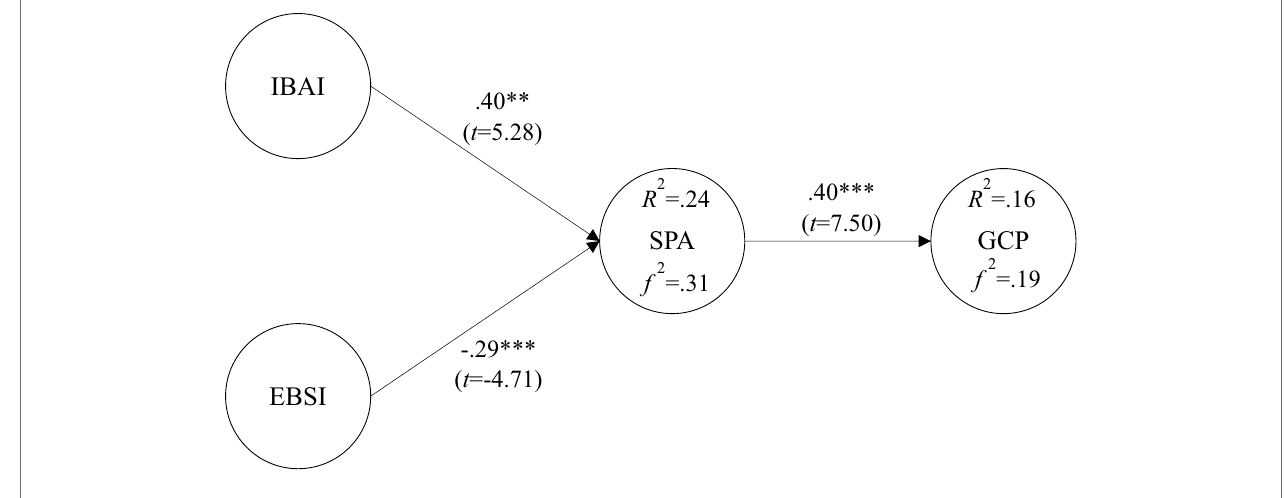
FIGURE 9 | Validation of the research model ( ** p < 0.01; *** p < 0.001 ).